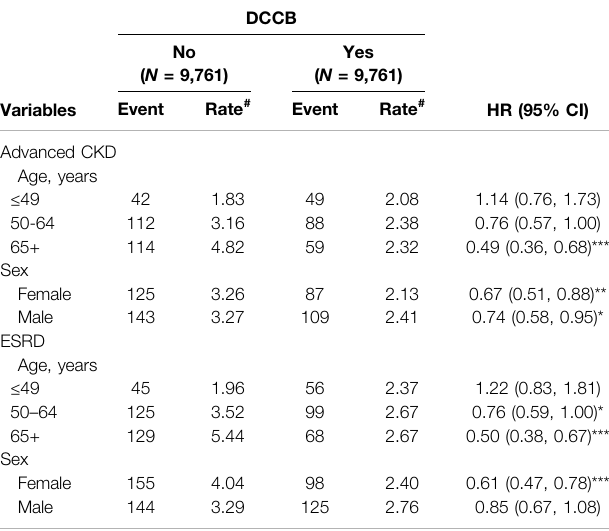
TABLE 3 | Incidence and hazards ratio of advanced CKD or ESRD measured by age, sex, and comorbidity in the dihydropyridine calcium channel blocker (DCCB) cohorts among diabetes mellitus patients with chronic kidney disease compared with those in the non-DCCB cohorts by Cox proportional hazard models with time-dependent exposure